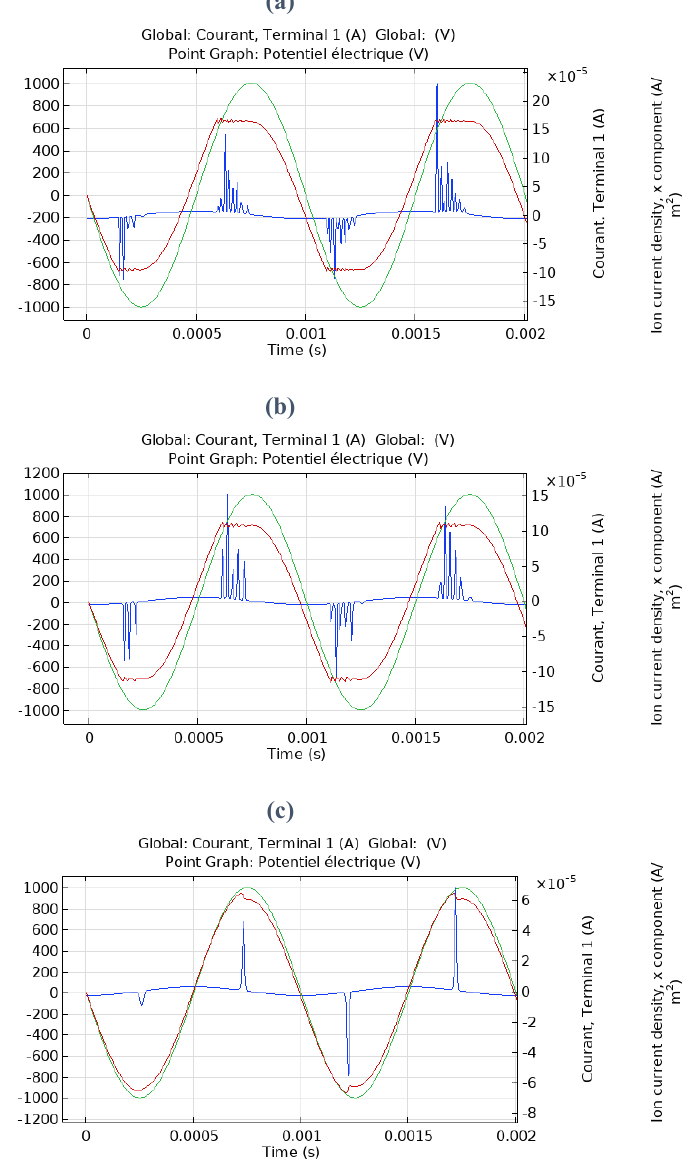
fig 8 : the variation of positive helium ion density, (in blue) next to the dielectric and (in green) next to the cathode with f = 1kHz and P = 760 Torr at different discharge distances (a)0.8mm, (b) 1mm and